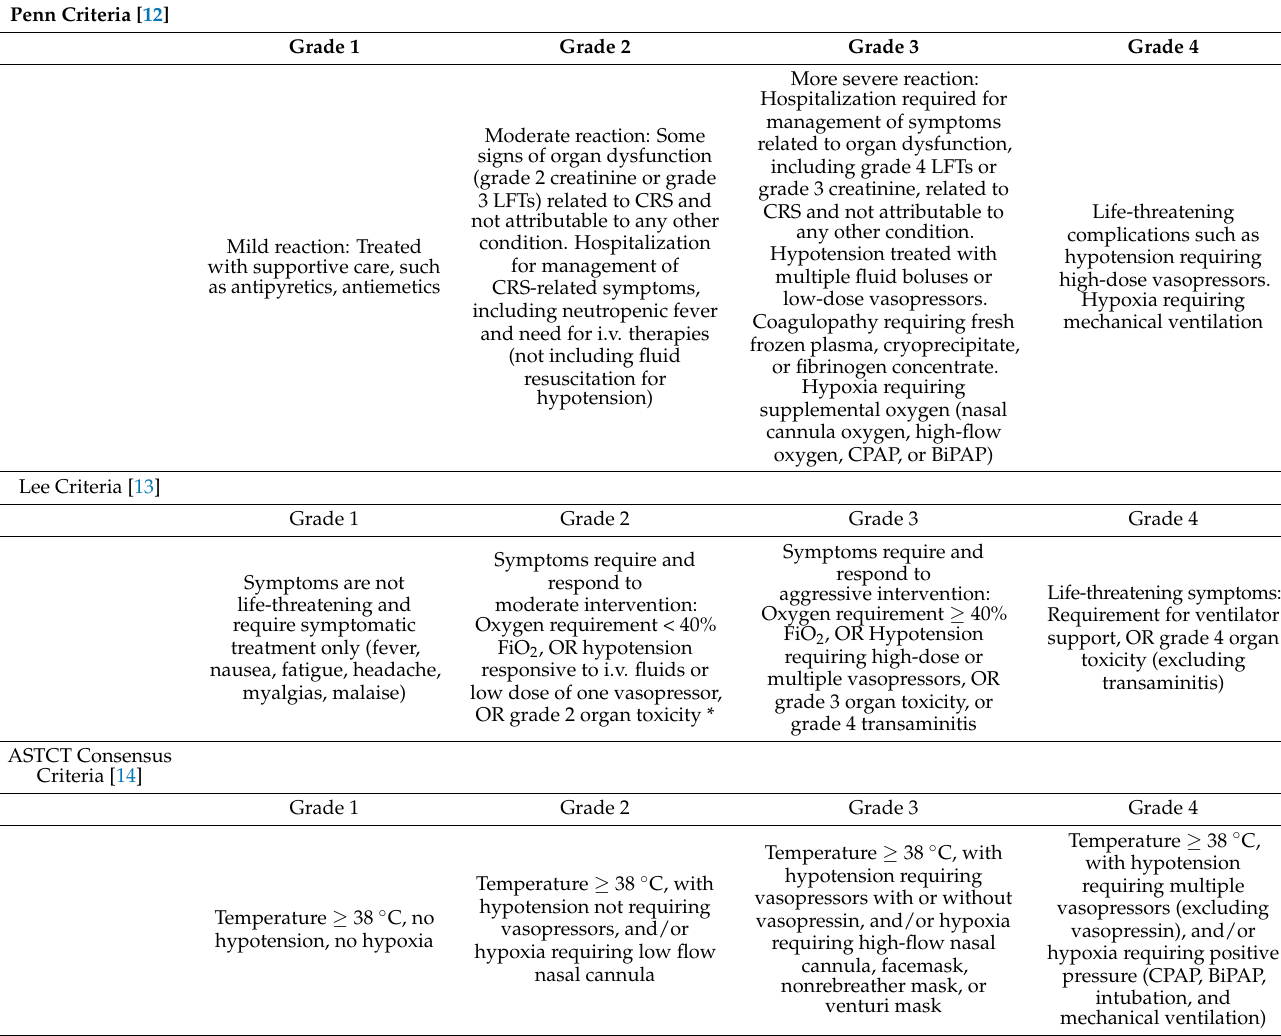
Table 1. Grading Criterias for CRS in the pivotal and included retrospective